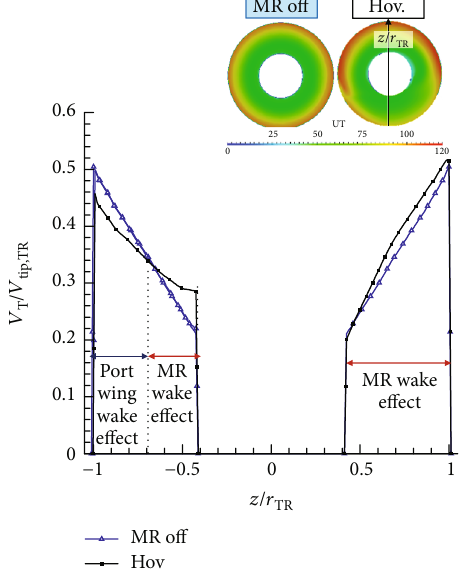
Figure 14: Circumferential velocity along the vertical